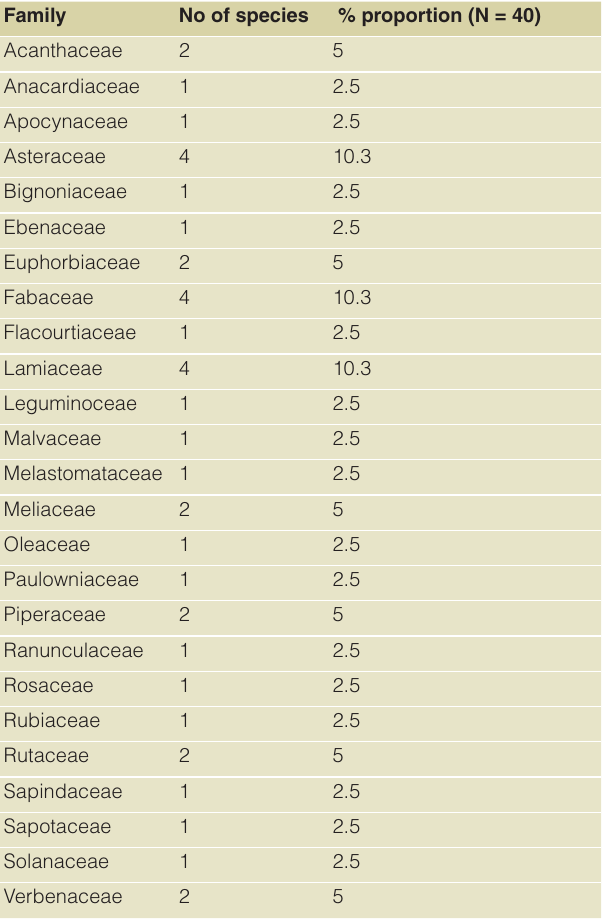
Table 2. Families and corresponding number of species of medicinal plants identified. Family